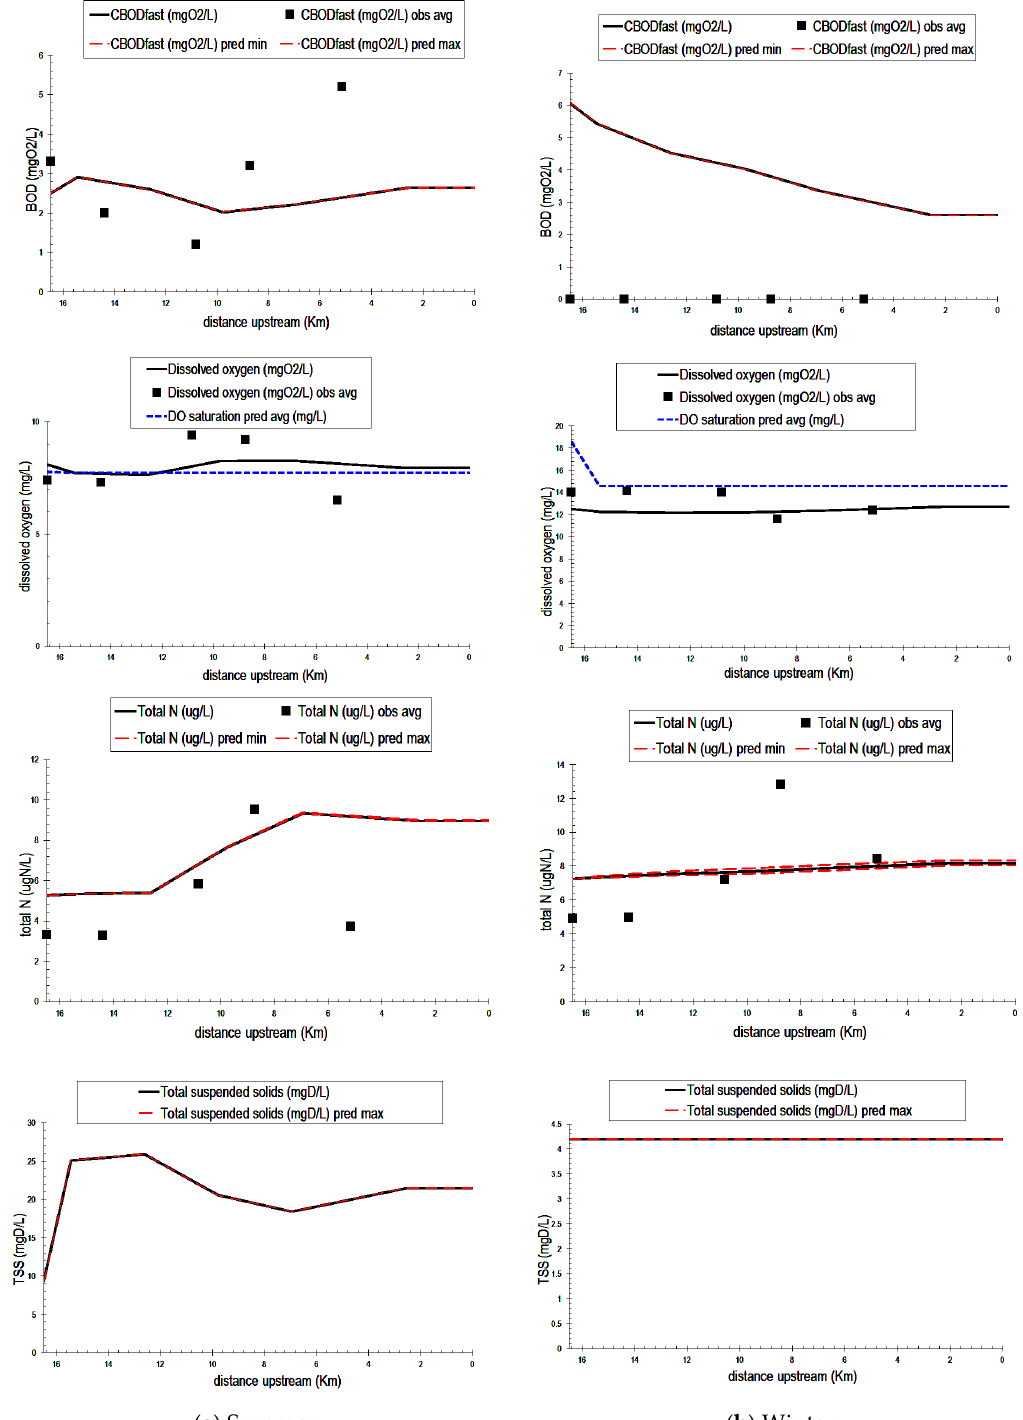
Figure 4. Water quality simulation 2016 results for the Osan stream drain.